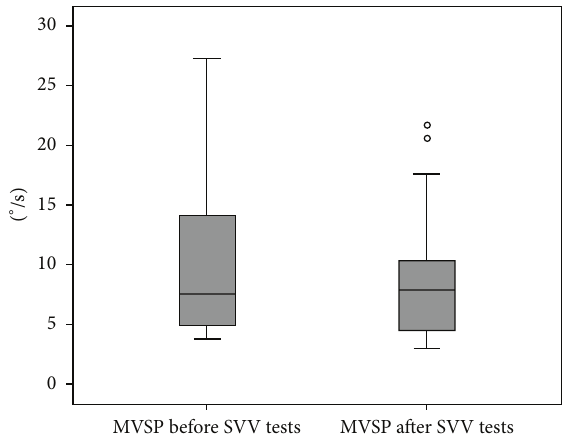
Figure 1: Box plot of nystagmus’ maximum velocity of slow phase (MVSP) before and after subjective visual vertical (SVV) tests. Wilcoxon signed rank test: p = 0.067.